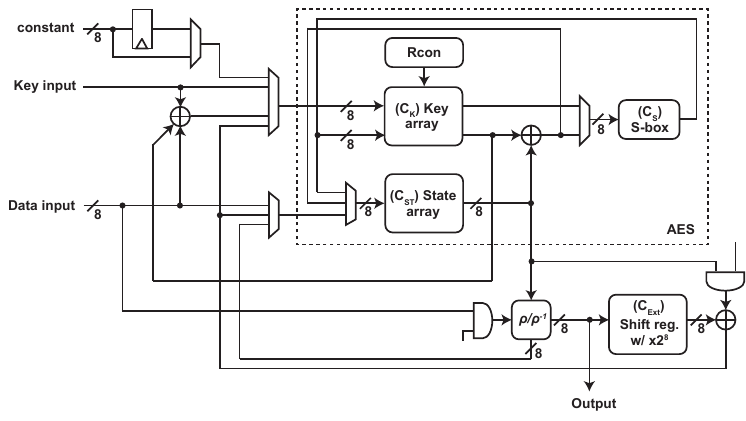
Figure 8: Datapath diagram of the Remus-N2-AES hardware